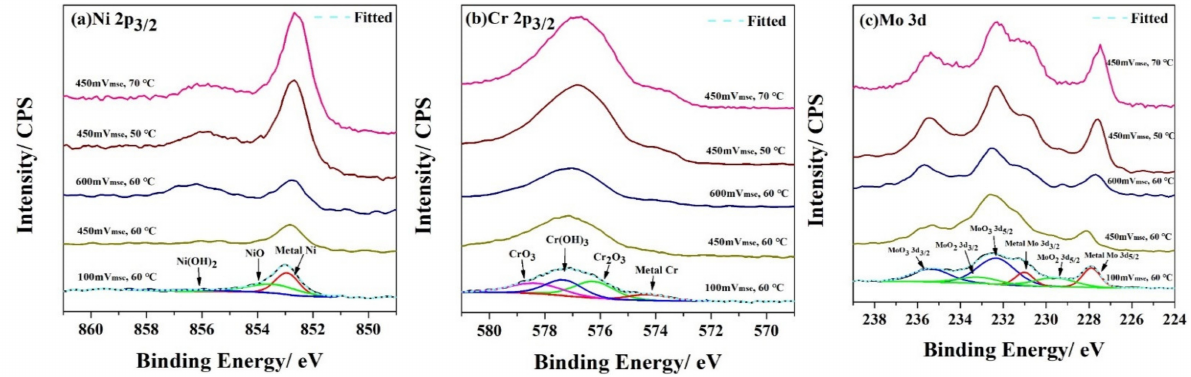
Figure 18. High-resolution XPS profiles for Ni 2p3/2 ( a ), Cr 2p3/2 ( b ) and Mo 3d ( c ) of the surface of the C22 coating after potentiostatic